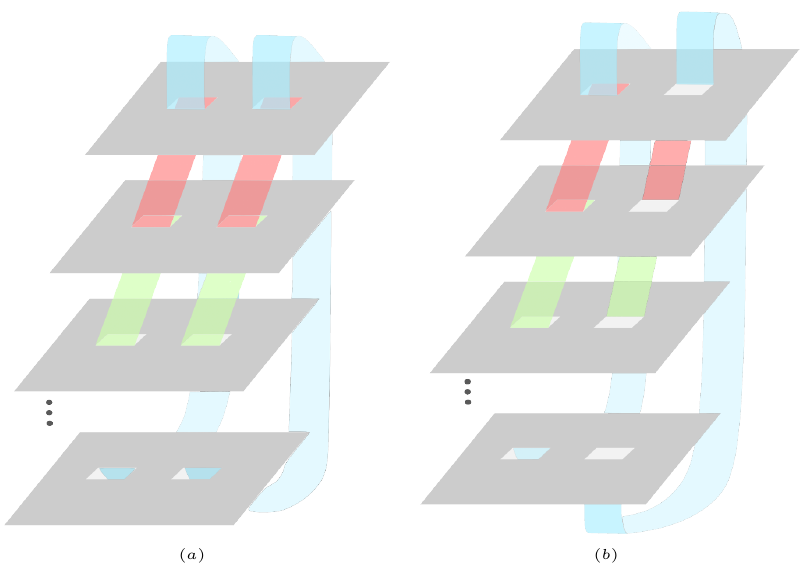
(cid:0) (cid:1) n ρ T 2 in